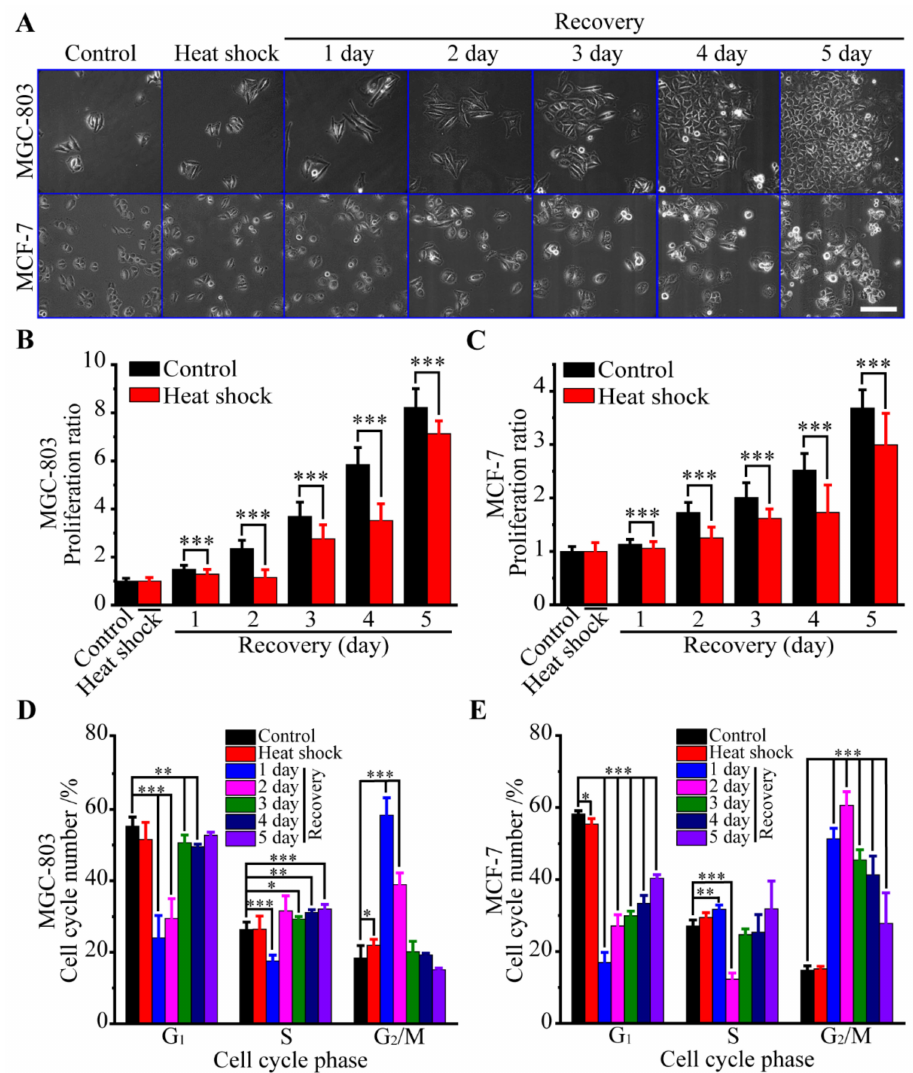
Figure 1. Biological responses of human cancer cells caused by heat stress. ( A ) Time-lapse images of MGC-803 and MCF-7 cells (scale bar: 200 µ m). ( B , C ) Cell proliferations of MGC-803 and MCF-7 cells, respectively (mean values ± SD are shown from three independent experiments). ( D , E ) Cell cycles of MGC-803 and MCF-7 cells, respectively (mean values ± SD are shown from three independent experiments). p -value < 0.05 was considered statistically significant, * p < 0.05, ** p < 0.01, and *** p <